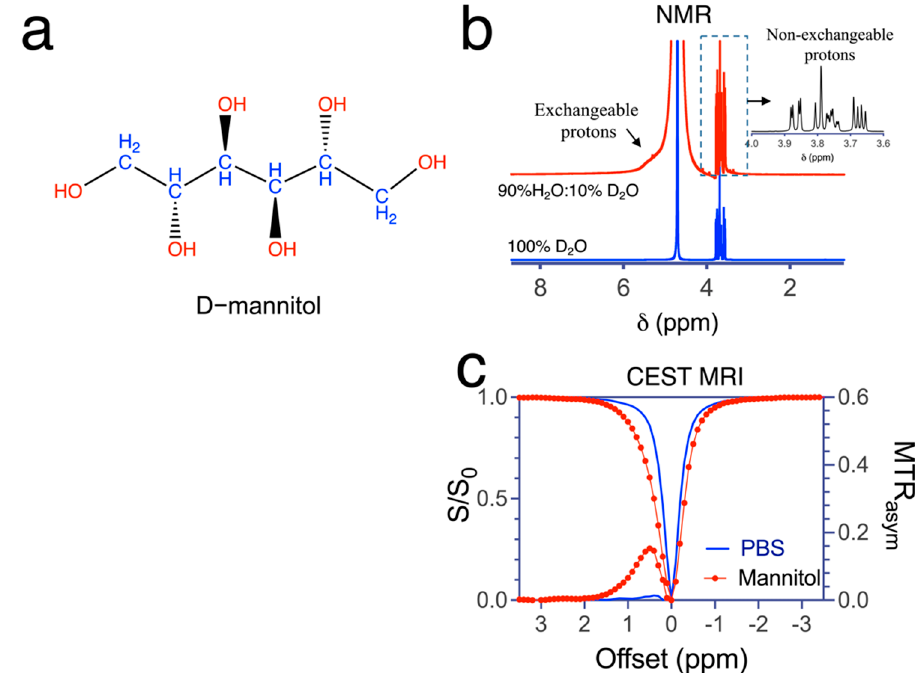
Figure 1. NMR and CEST MRI signal of mannitol ( a ) Chemical structure of mannitol. Red: functional groups containing exchangeable protons; blue: functional groups containing non-exchangeable protons. ( b ) NMR spectra of 100 mM mannitol (pH 6.5) in D 2 O (bottom, blue line) and H 2 O (top, red line, H 2 O: D 2 O = 90%:10%) at pH = 7.4 and room temperature. ( c ) Z-spectra and MTR asym plots of 20 mM mannitol (PBS solution, pH 7.2, 37 °C) in PBS and blank PBS solution. CEST MRI was acquired using a CW pulse (B 1 = 1.8 µT and T sat = 4 s).